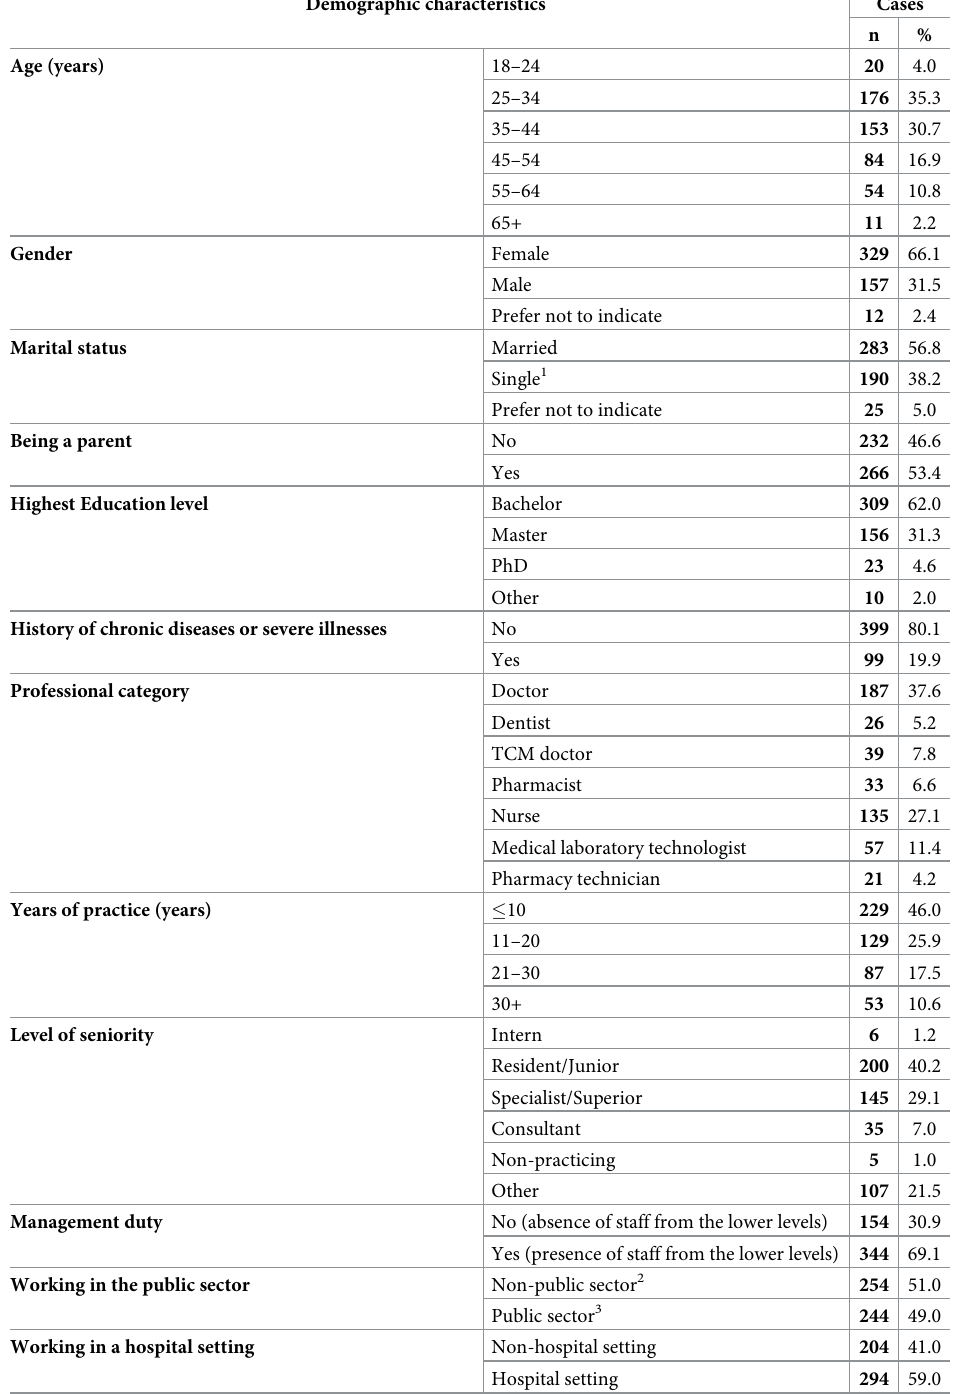
Table 2. Descriptive information about the respondents (n =